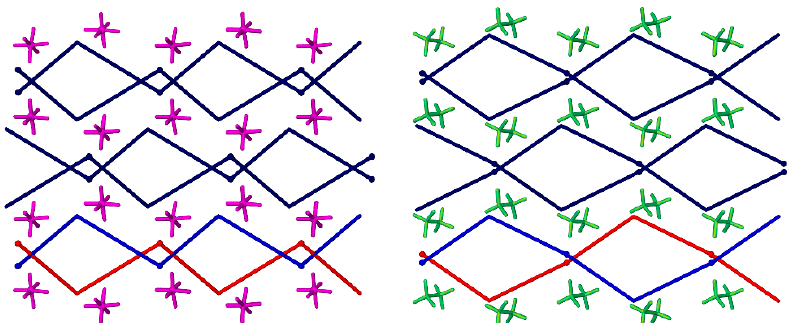
Figure 6. Simplification of the crystal packing in 2 ( left ) and 4 ( right ) shown down the c axis, indicating the positions of the silver atoms and the carbon atom of the methyl group on the benzene ring, in the bottom layer, two selected 1D chains are presented in red and blue respectively to indicate the difference, silver atoms shown as balls.